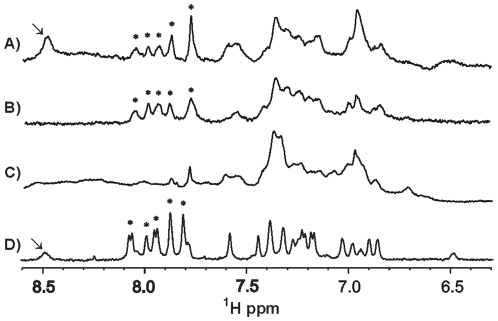
Sections of ligand detected 1D 1H-NMR spectra from the analysis of weak molecular interactions between dark state YtvA and BODIPY-GTP.WaterLOGSY (A) and STD-Watergate (B) of 20 µM YtvA mixed with 200 µM BODIPY-GTP. Watergate of (C) 20 µM dark state YtvA and (D) 200 µM BODIPY-GTP. Signals of protons from the aromatic BODIPY part are marked by asterisks. Exchangeable ligand protons are marked by arrows.